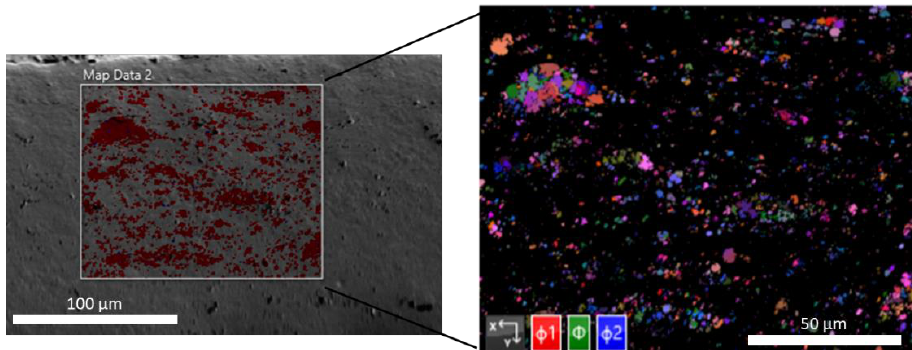
Figure 9. EBSD (Euler map) of bond coat for the as-received sample. After heating, the TBC samples exhibited improved crystallinity, and EBSD mapping can be generated. The grain size distribution and orientation based on Euler angle maps for the DL-TBC after exposure for thermal loading of 1150 °C for 1, 10, and 100 h are shown in Figure 10. For the bond coat (Figure 10a), it was found that average grain size (dashed line) increased from 1.2 ± 0.6 µm to 1.6 ± 0.8 µm and 2 ± 1.3 µm, respectively. Also, the count of detected grains shown in the line graph (see Figure 10a), reduced from increased treatment duration from 1 h (4356 grain) to 100 h (1349 grain), is another indication for the